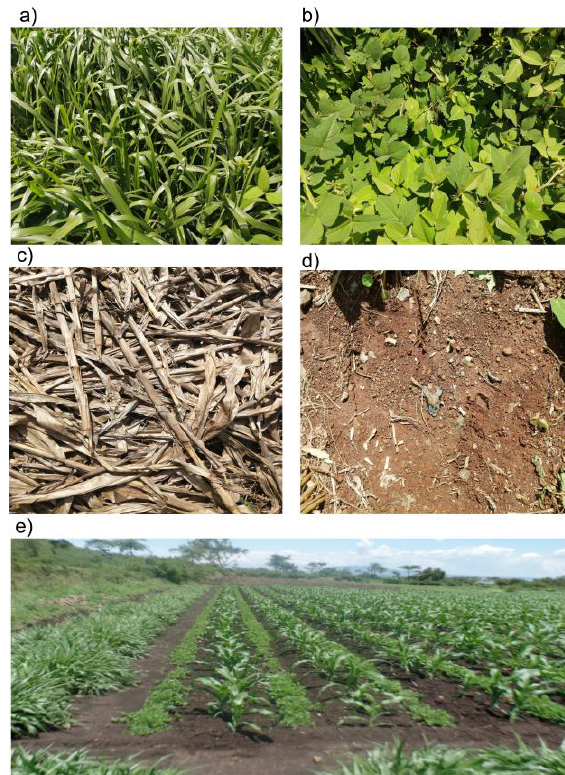
Figure 1. ‘Push-pull’ components and cropping system (a) Brachiaria (pull crop), (b) greenleaf Desmodium (push crop), (c) maize stover and (d) bare soil and (e) ‘push-pull’ cropping